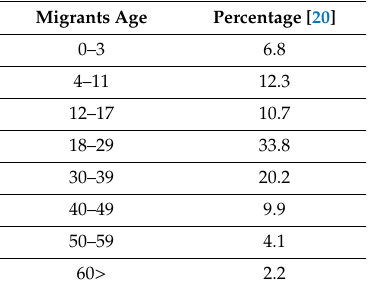
Table 1. Age distribution with corresponding percentage of total recently arrived migrants in the Netherlands in 2017.